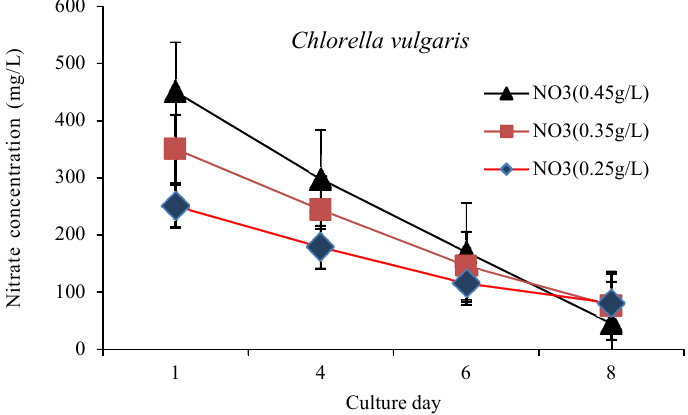
Fig. 1: Comparing the mean and standard deviation of remaining nitrate